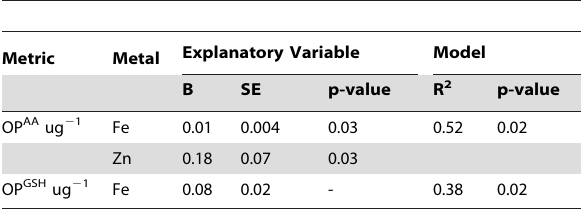
Table 2. Parameters of multi-variate linear regression models to explain PM 10.2 oxidative potential metric variance.